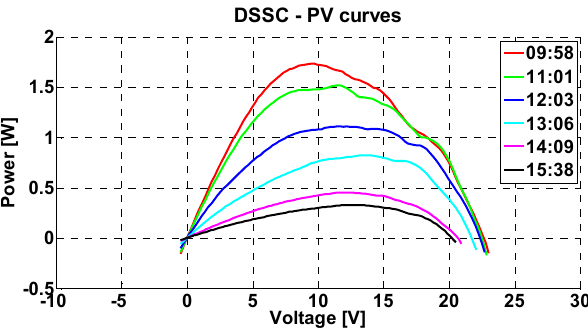
Figure 15. DSSC cell power-voltage curves for different irradiance values.